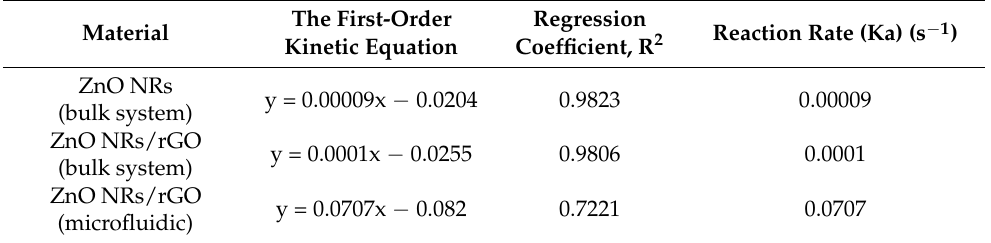
Figure 6. Correlation of ln (C 0 /Ct) and reaction time ( a ) bulk system and ( b ) microfluidic system. Table 6. First-order kinetic equation and correlation coefficient R 2 of the MB degradation reaction of the